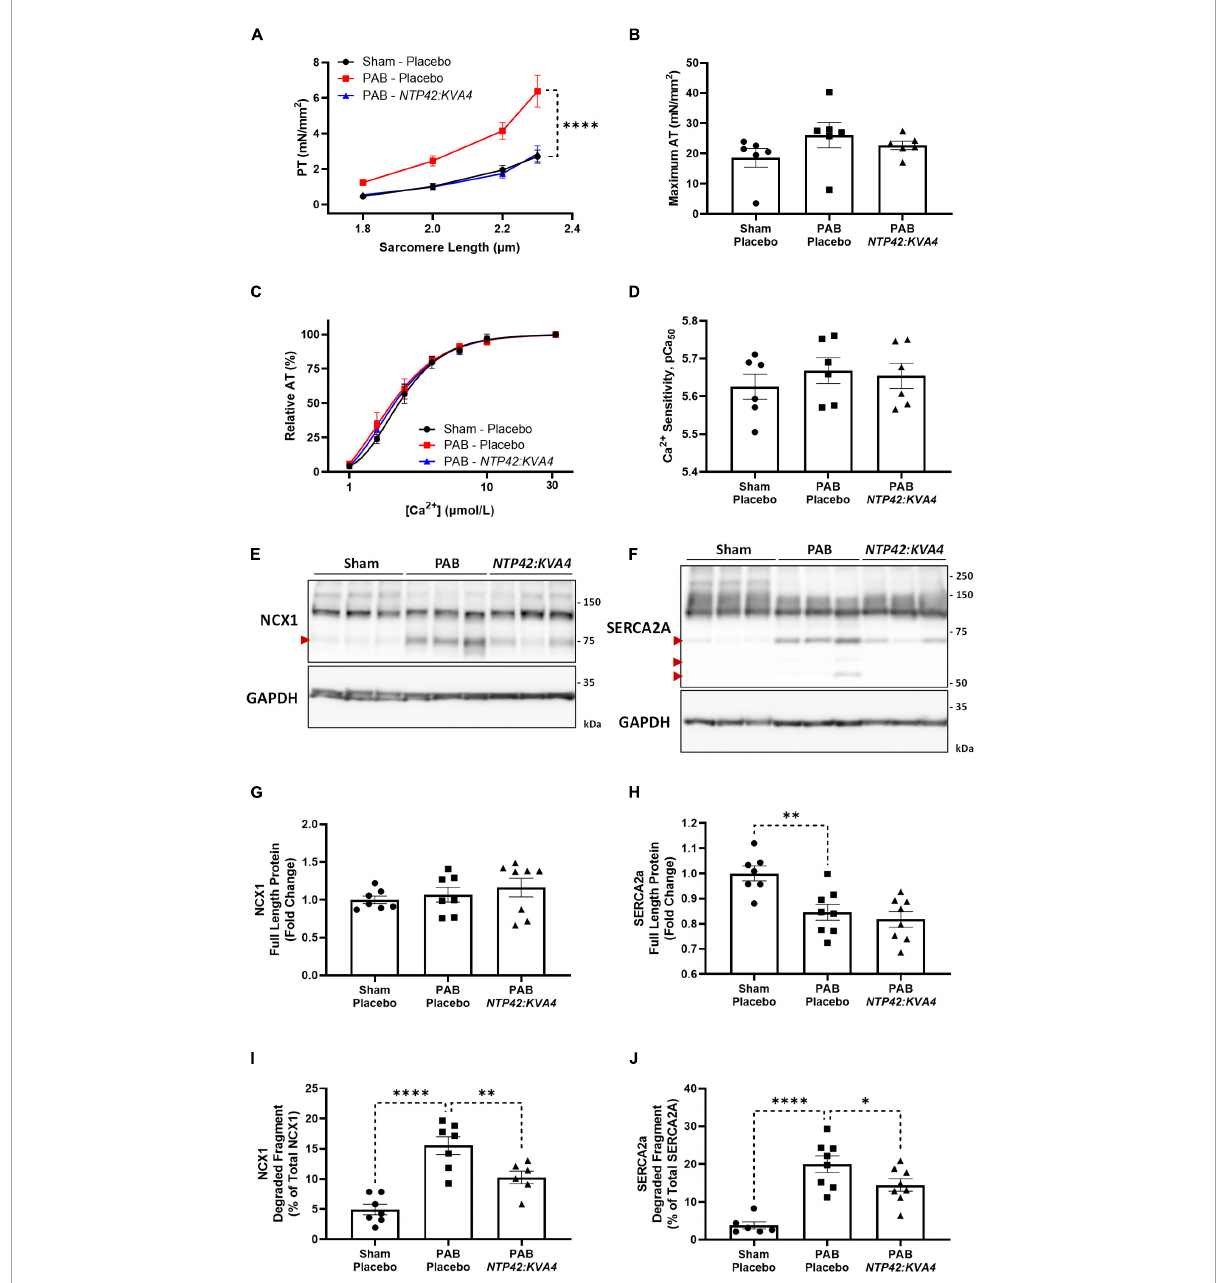
FIGURE5 Effect of NTP42:KVA4 treatment on isolated cardiomyocyte force transduction and calcium-handling protein expression in the PAB model. (A–D) show: (A) Steady-state PT measured at increasing sarcomere lengths (1.8–2.3 µ m) from cardiomyocytes isolated from animals in the “Sham—Placebo,” “PAB—Placebo,” and NTP42:KVA4 groups [ n = 6, 6, and 6, respectively]; (B) Maximum AT development at [Ca 2 + ] 31.6 µ mol/L [ n = 6, 6, 6]; (C) Relative AT development in response to increasing submaximal free Ca 2 + concentration ([Ca 2 + ], 1–31.6 µ mol/L) [ n = 6, 6, 6], where calcium response curves were fitted using non-linear regression, and (D) Calcium sensitivity (pCa 50 ) determined from individual regression analyses [ n = 6, 6, 6]. (E,F) Show western blot protein expression of: (E) NCX1 and (F) SERCA2a, where representative RV lysates are displayed from 3 random animals from each treatment group and glyceraldehyde-3-phosphate dehydrogenase (GAPDH) expression levels were used as loading control. The relative positions of the molecular size markers (kDa) are indicated to the right of the panels and the positions of the observed degraded fragments of NCX1 and SERCA2a are marked with red arrowheads to the left of the panels. (G–J) Show mean relative RV expression levels of (G) NCX1 full-length protein (120 kDa) [ n = 7, 7, 8]; (H) SERCA2a full-length protein (110 kDa) [ n = 7, 8, 8]; (I) NCX1 75 kDa degraded fragment, expressed as a percentage of total NCX1 [ n = 7, 7, 6], and (J) SERCA2a 70 kDa degraded fragment, expressed as a percentage of total SERCA2a [ n = 6, 8, 8]. Data presented are the mean ± SEM, and where in (A–D) , results are presented from 6 animals per group, with an average of 5 independent cardiomyocytes (technical replicates) analyzed per animal. * P < 0.05, ** P < 0.01, **** P < 0.0001 vs. “PAB—Placebo,” according to two-way ANOVA with Holm-Šídák correction (A,C) or one-way ANOVA with Holm-Šídák correction (B,D,G–J)